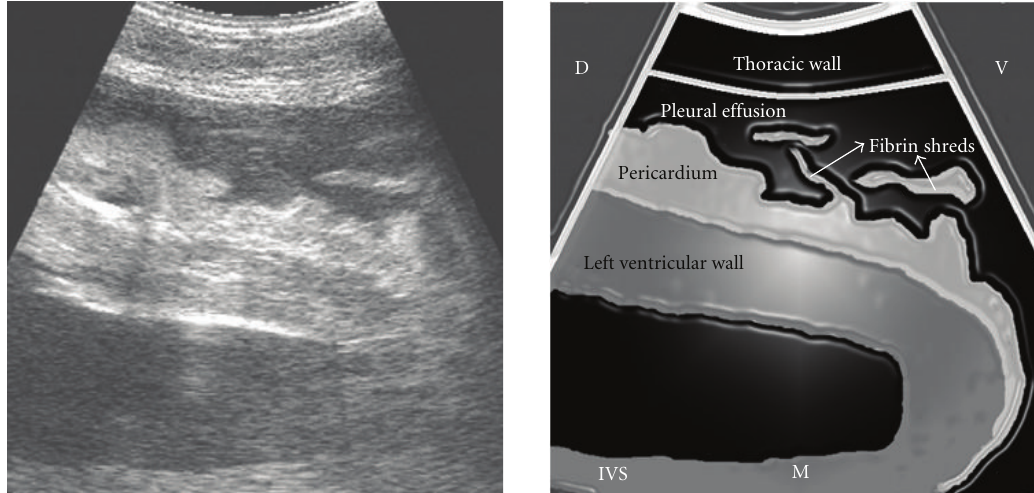
Figure 6: Two-dimensional echocardiogram obtained from the left 5th ICS, showing pleural e ff usion and thickened pericardium with fibrin shreds deposited on its surface. ICS: intercostal space; IVS: interventricular septum; D: dorsal; V: ventral; M: medial.